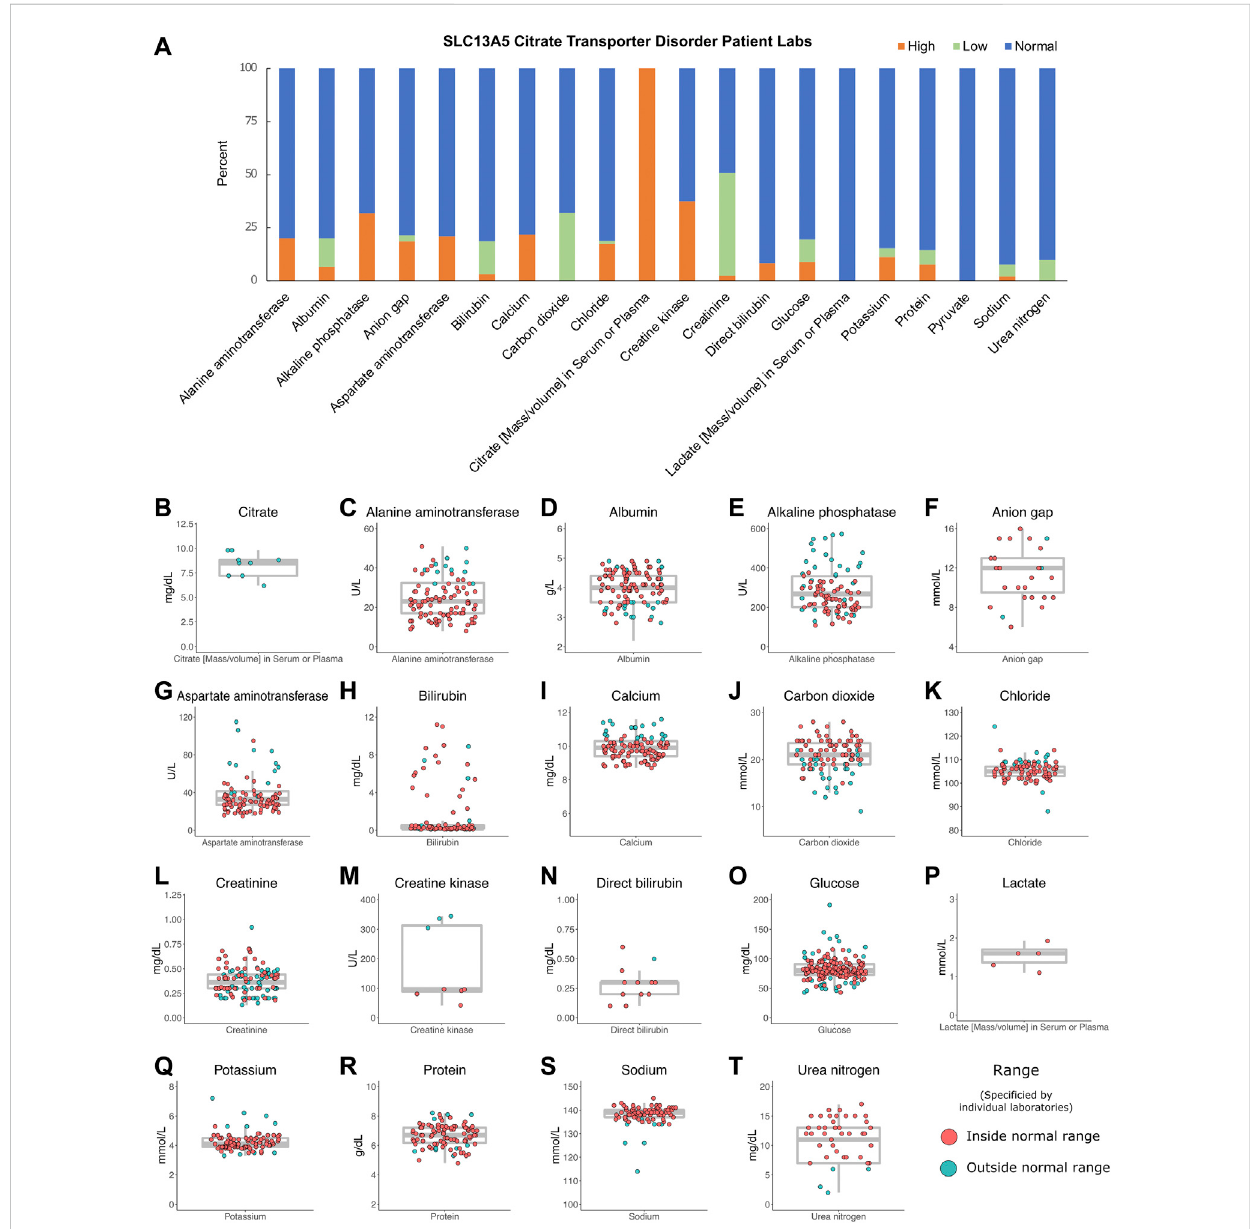
Patient labs. (A) Percentage of patient labs as high, normal, or low. Evaluation of high, normal, and low values was determined for each individual laboratory assessed and compared to reference levels provided by each institution. (B – T) Individual labs by patient, n = 2,251. Gray box indicates the median, interquartile ranges, and minimum and maximum values without outliers. The color indicates labs inside or outside the normal range, as determined by individual laboratory